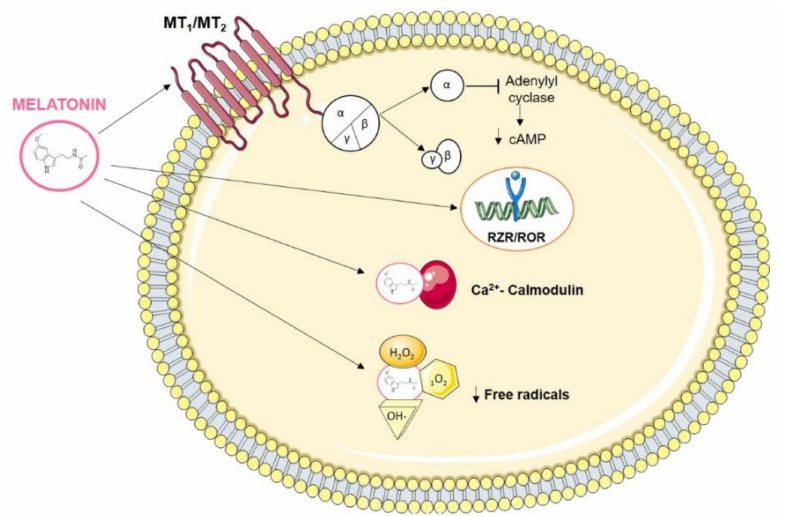
Figure 2. Mechanisms of action of melatonin. Melatonin can bind to its specific membrane receptors (MT1, MT2), to orphan nuclear retinoic acid receptors (RZR/ROR- α and RZR β ), and interacts with calmodulin to carry out its action. Also, melatonin can act as a free radical scavenger, stimulating the expression of antioxidant enzymes and protecting cells from oxidative